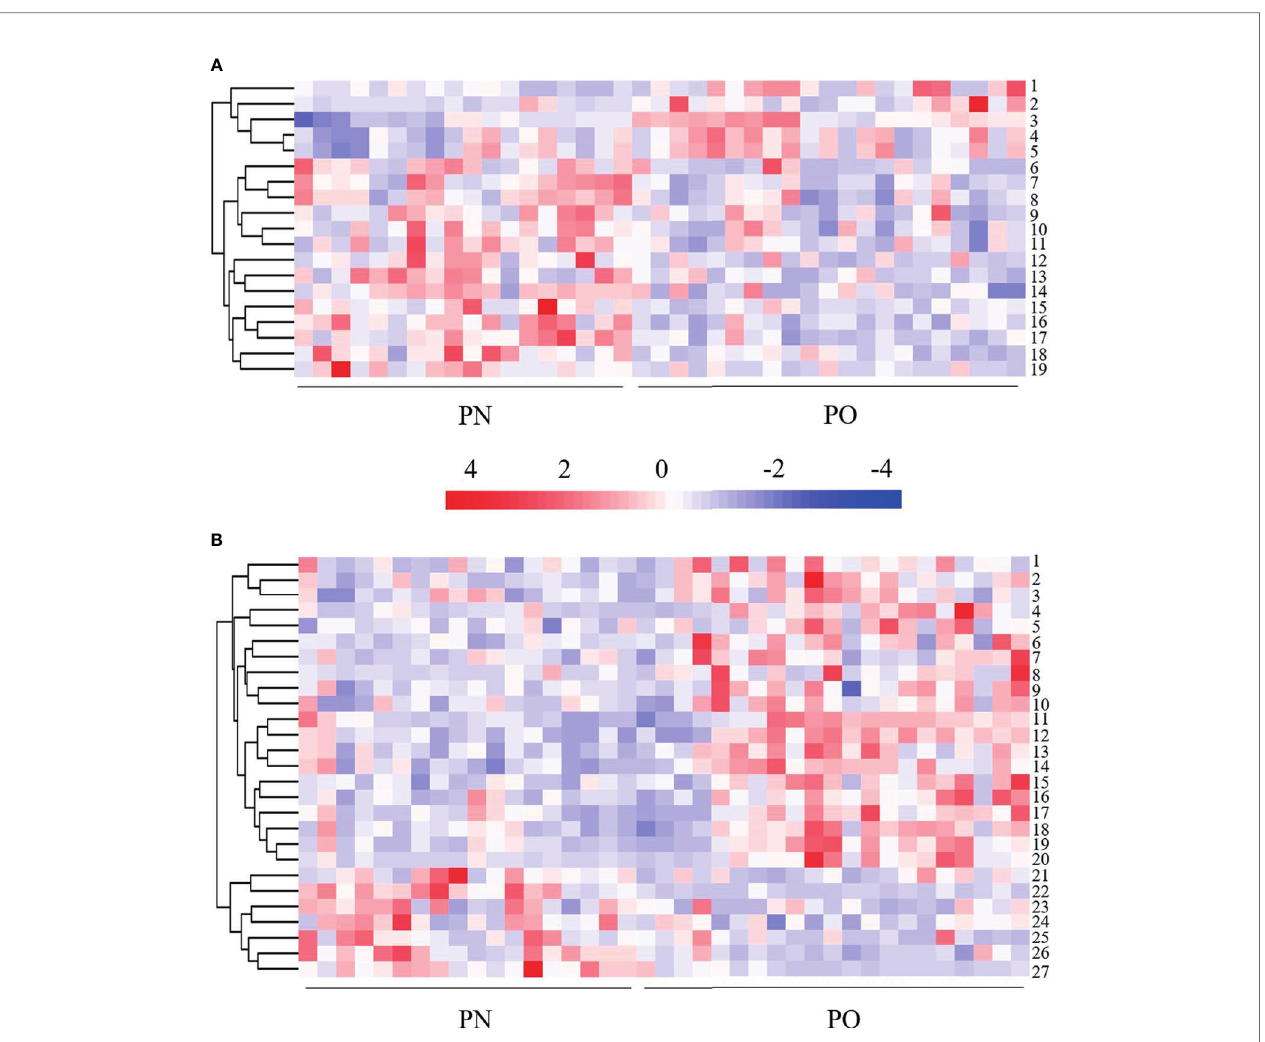
FIGURE 4 | Heat map of hierarchical clustering analysis of the differentially expressed metabolites. (A) POS mode. 1 = D -ornithine, 2 = PC (16:0/16:0), 3 = L -arginine, 4 = pseudouridine, 5 = a - D -glucose 1-phosphate, 6 = glutaric acid, 7 = L -pipecolic acid, 8 = 3-mercapto-2-butanone; 9 = L -proline, 10 = dihydrolipoic acid, 11 = lle-Ala, 12 = Leu-Leu, 13 = myristoleic acid, 14 = xanthylic acid, 15 = Gly-Glu, 16 = N -acetylglutamine, 17 = His-Met, 18 = L -pyroglutamic acid, 19 = D -glucuronate. (B) NEG mode. 1 = indoleacetic acid, 2 = atrolactic acid, 3 = indolelactic acid, 4 = L -threonate, 5 = 5-methoxyindoleacetate, 6 = 3,4- dihydroxymandelic acid, 7 = azelaic acid, 8 = hydrocortisone 21-acetate; 9 = L -tyrosine, 10 = N -acetyl- L -tyrosine, 11 = DL -lactate, 12 = dihydrothymine, 13 = myristic acid, 14 = palmitic acid, 15 = L -valine, 16 = L -leucine, 17 = xanthine, 18 = L -alanine, 19 = L -glutamate, 20 = thymine, 21= N -acetyl- D -galactosamine, 22 = fructose 1- phosphate, 23 = 3-hydroxycapric acid, 24 = L -histidinol phosphate, 25 = 2-deoxyribose 5-phosphate, 26 = a - N -acetyl- L -glutamine, 27 = L -gulonic